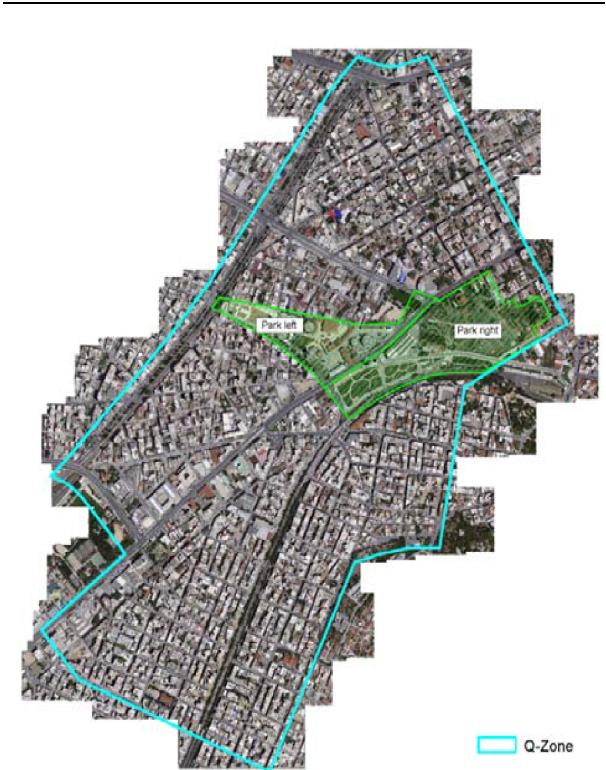
Figure 1: Q-Zone (test site) and the investigated park in Athens. The park is divided into two sections for evaluation (Park left and Park